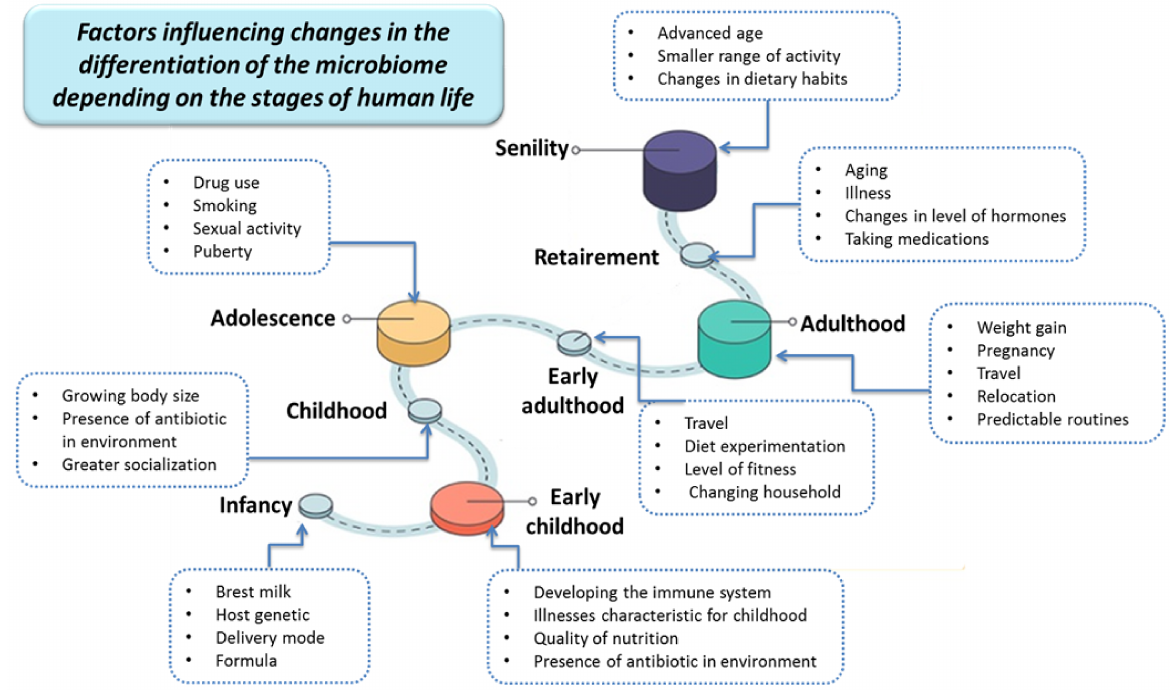
Figure 1. Factors influencing changes in the differentiation of the microbiome depending on the stages of human life (based on [11]). Table 1. Diversity of enterotypes of intestinal microorganisms depending on the type of microorganisms, energy source, vitamin production capacity and dietary components (based on